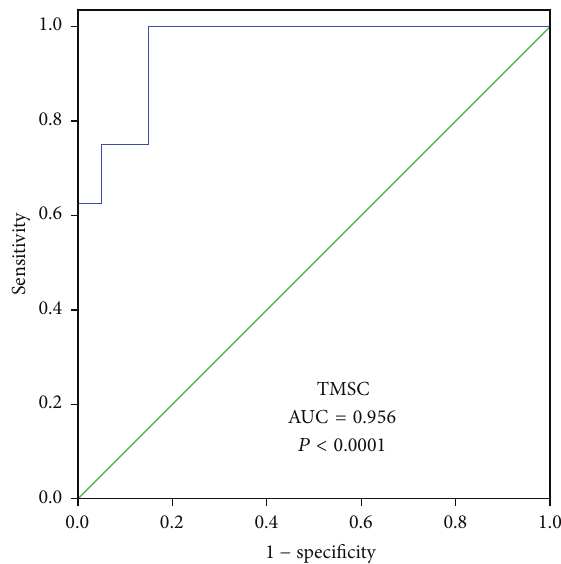
Figure2:TMSCdiagnosticutilityfornaturalpregnancyoccurrence (ROC analysis).